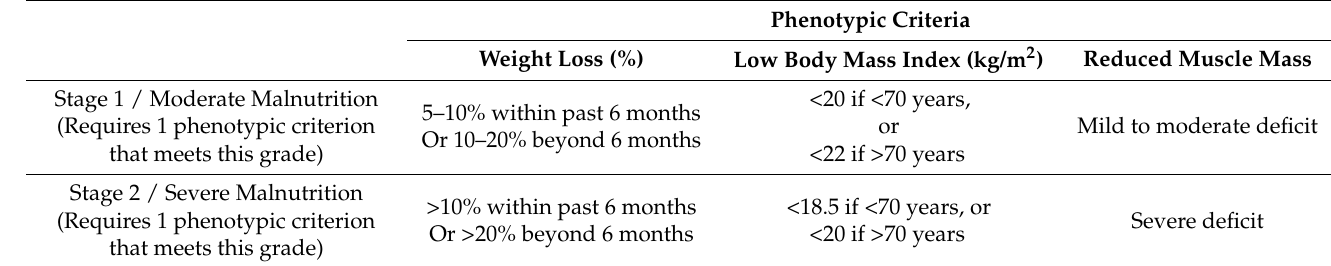
Table 3. Criteria for the severity of malnutrition